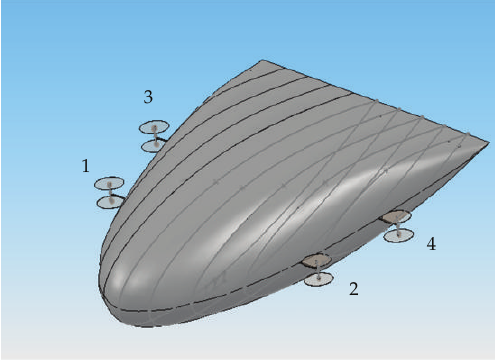
Figure 2: Position of the